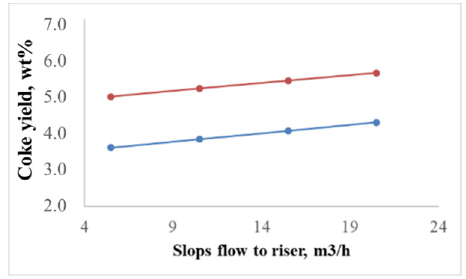
Figure 9. Effect of the slop flowrate relative to riser on coke yield.